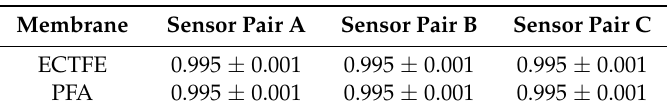
Table 4. Retention capacities of the H 2 -selective ECTFE and PFA membranes. The values given are the arithmetic mean and standard deviation of ten measurements at 150 ppm H 2 .